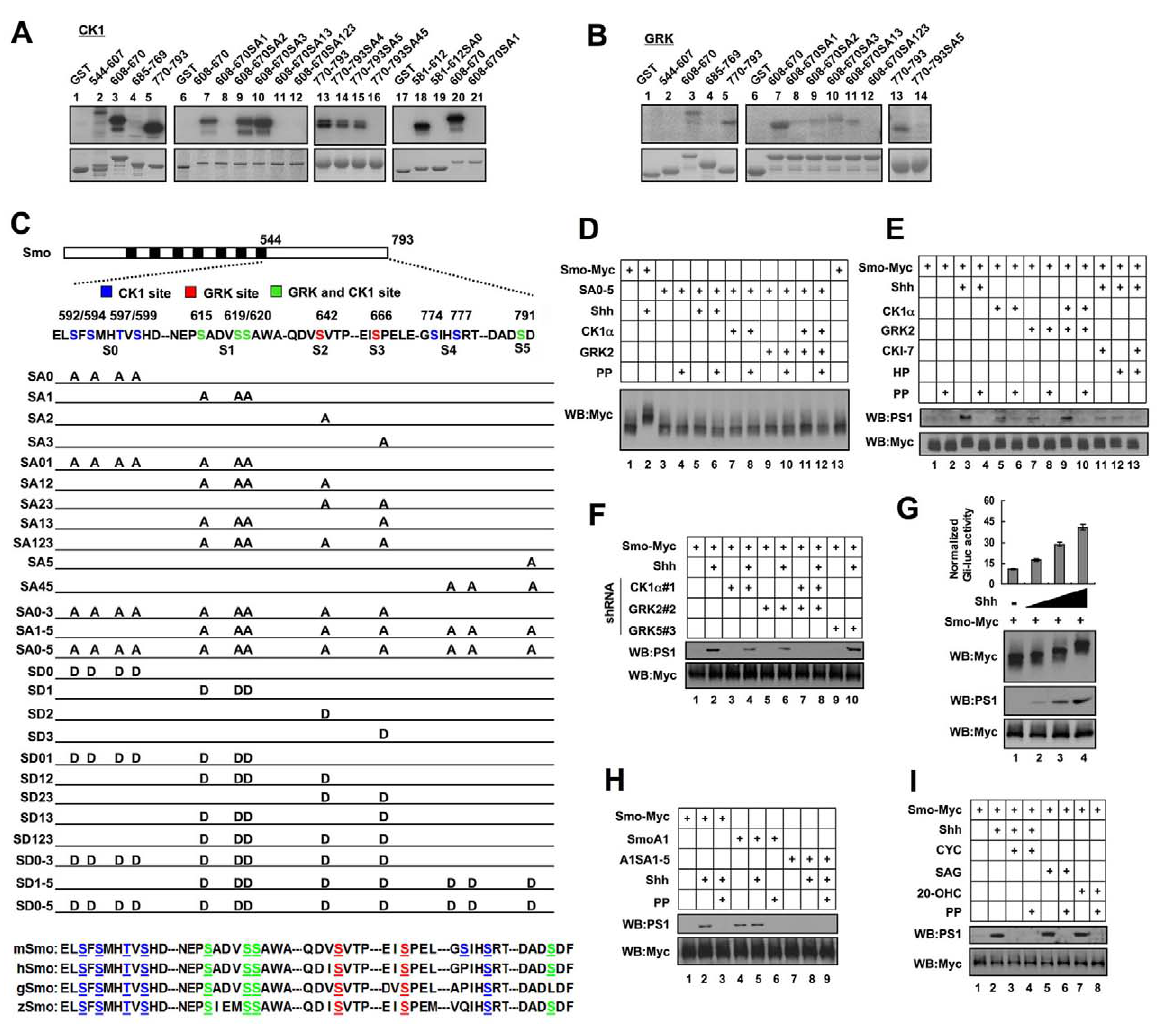
Figure 2. CK1 and GRK phosphorylate multiple sites in Smo C-tail. (A–B) In vitro kinase assay using a recombinant CK1 d or GRK5 and purified GST-fusion proteins carrying indicated Smo fragments. (C) A schematic drawing of a full-length Smo with the sequences of the six CK1/GRK phosphorylation sites shown underneath (S0–S5) and color coded: blue for CK1 specific sites; red for GRK specific sites; green for sites phosphorylated by both CK1 and GRK. Smo variants with the indicated substitutions are listed. Sequence alignment shows that the CK1/GRK phosphorylation sites are highly conserved among Mouse (m), Human (h), Chick (g), and Zebrafish (z) Smo proteins. (D) Cell extracts were prepared from NIH 3T3 cells transfected with Smo-Myc or SmoSA0–5-Myc and with or without cotransfection of the indicated kinase expressing constructs and treated with or without Shh-conditioned medium. The extracts were separated on Phos tag-conjugated SDS-PGAE gel and immunoblotted with an anti-Myc antibody. PP indicates l -phosphatase treatment. (E) Cell extracts were prepared from NIH 3T3 cells transfected with Smo-Myc and with or without indicated kinase expressing constructs, followed by treating with or without Shh-conditioned medium or indicated kinase inhibitors. The extracts were subjected to SDS-PAGE, followed by immunoblotting with the PS1 antibody. The membrane was stripped and probed with Myc antibody for Smo-Myc. (F) Cell extracts prepared from shRNA lines targeting CK1 a , GRK2, or GRK5 transfected by Smo-Myc and treated with or without Shh- conditioned medium were analyzed as in (E). (G) NIH 3T3 cells were transiently transfected with Smo-Myc and treated without or with increasing levels of ShhN peptides (1 nM, 2 nM, 5 nM). 8XGliBS-luc activities were normalized by control pRL-TK . Cell extracts were separated on Phos tag- conjugated (top panel) or regular SDS-PAGE gel (bottom two panels), followed by immunoblotting with Myc or PS1 antibody. (H–I) Cell extracts from NIH 3T3 cells transfected with the indicated constructs and treated with or without Shh-conditioned medium, CYC (cyclopamine; 10 m M), SAG (200 nM), or 20-OHC (20 a -hydroxycholesterol; 10 m M) were separated on SDS-PAGE gel and probed with PS1 antibodies. The membranes were stripped and probed with Myc antibody to monitor Smo-Myc levels.